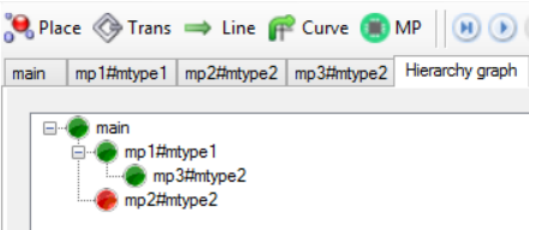
Figure 9. The hierarchy graph for the subnet from Figure